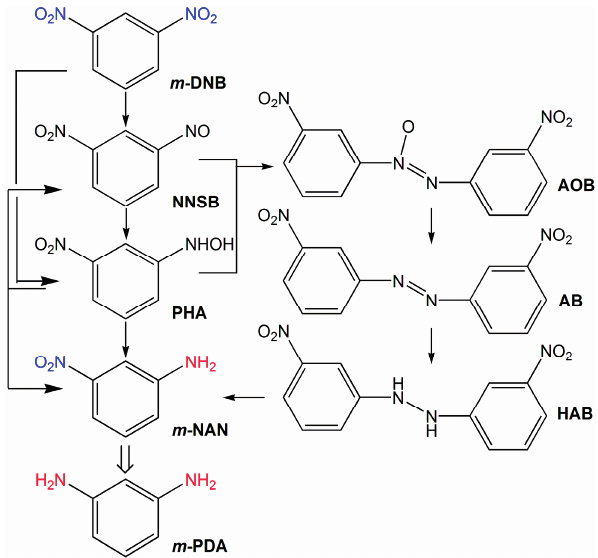
Scheme 1. Possible reaction pathway for the hydrogenation of m -dinitrobenzene. m -DNB, m -dinitrobenzene; NNSB, m -nitro-nitrosobenzene; PHA, m